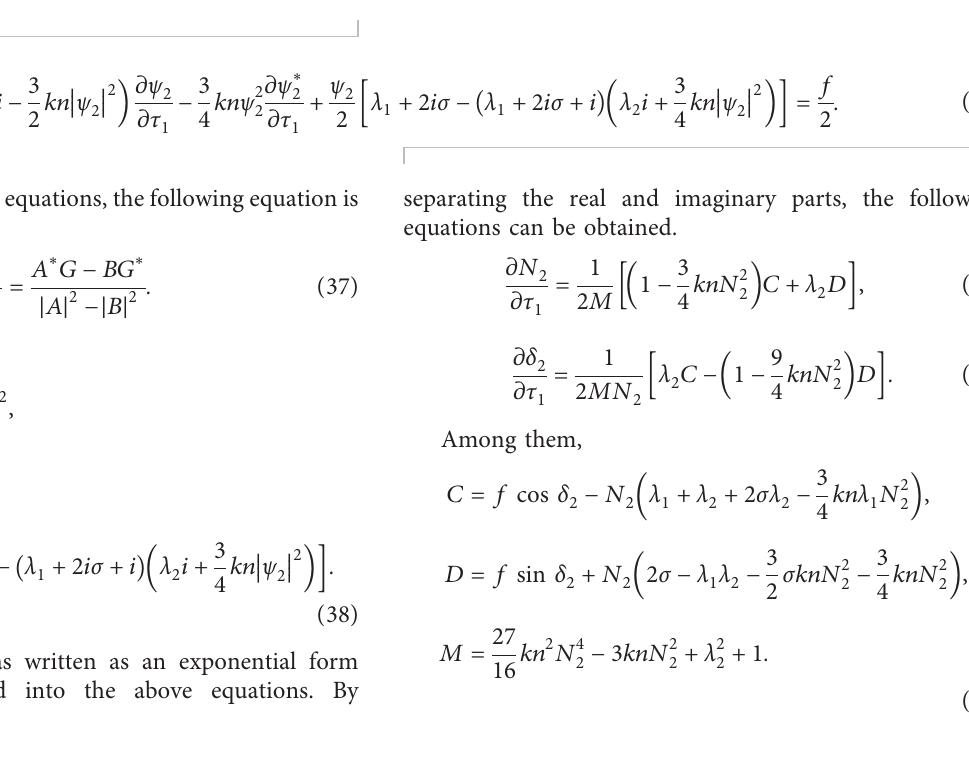
� 0 . 8 ; λ � 0 . 3 ; kn � 5 ; f � 0 . 1 2